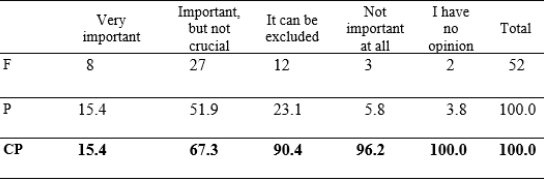
Table 17. Student’s attitudes about the